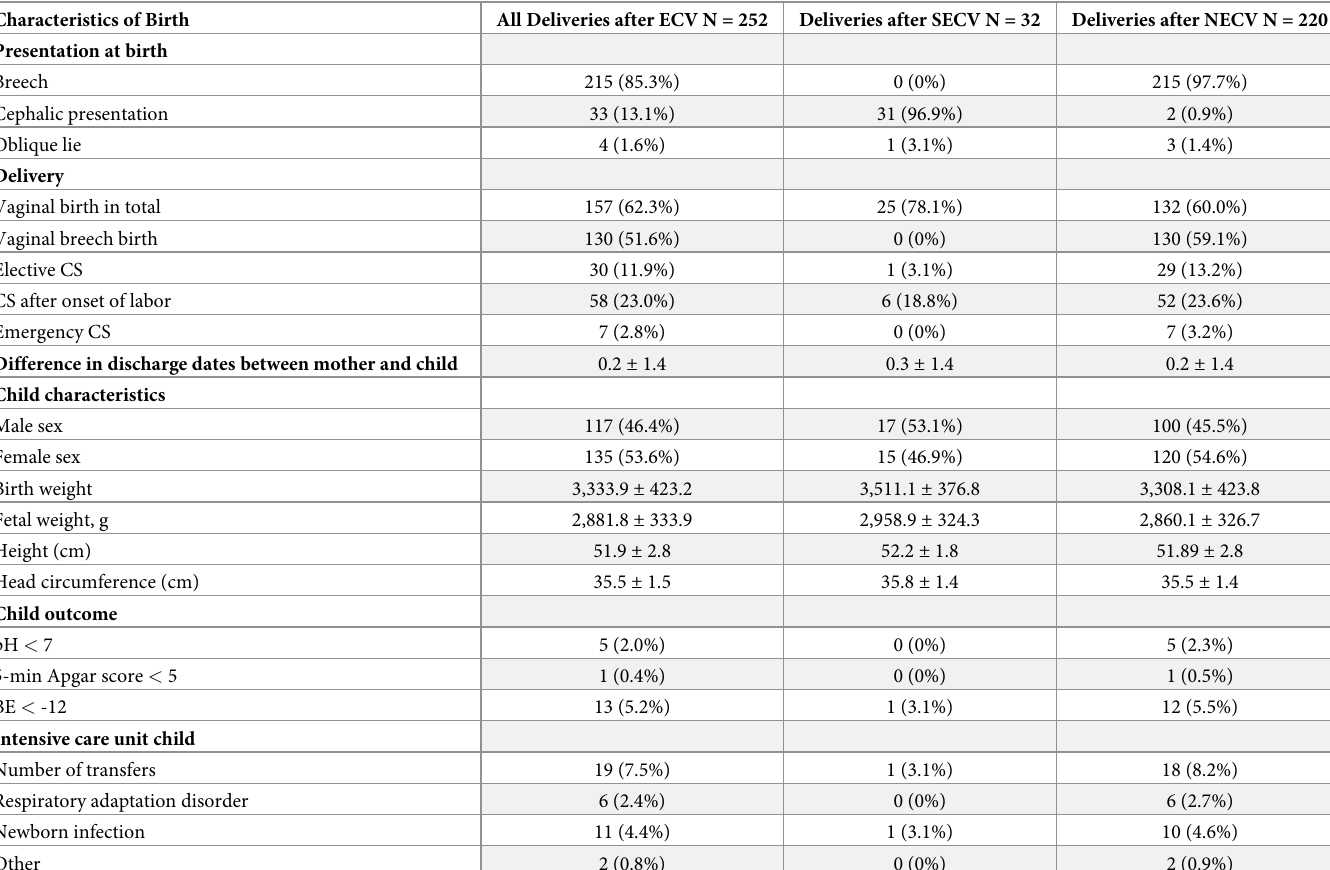
Table 4. Characteristics of birth.